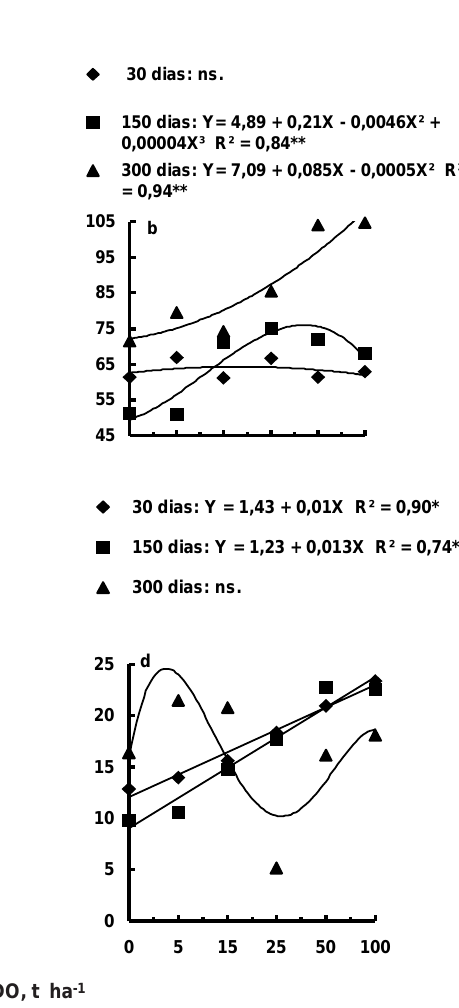
Figura 9. Capacidade de troca de cátions (CTC) em um Latossolo Vermelho-Escuro e em um Podzólico Vermelho-Amarelo incubados com doses crescentes de basalto microcristalino (respectivamente, figura 9a, c) e de olivina-basalto (respectivamente, figura 9b, d), após 30, 150 e 300 dias de